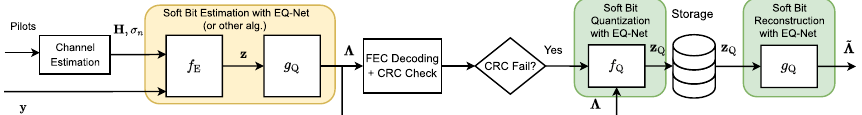
Fig. 3 Block diagram showing the deployment of EQ-Net in a MIMO receiver system architecture. The model g Q is shared between the estimation and quantization